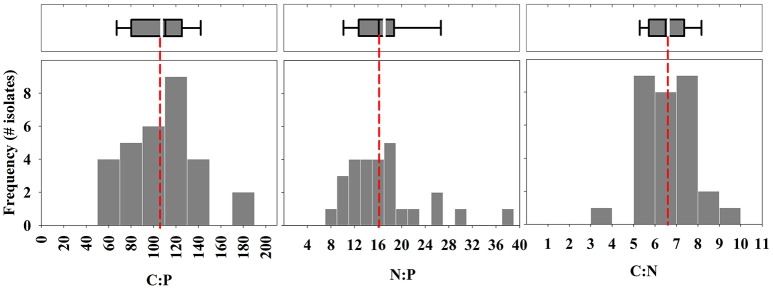
Frequency of isolates within binned intervals of molar elemental ratios of carbon, nitrogen, and phosphorus. Bin intervals for C:P, N:P, and C:N are 20, 2, and 1, respectively. Top box-whisker plots include the mean (white line) and median (black line) of ratios for all 30 isolates. The box indicates quartiles and the dotted line provides a reference to the Redfield ratio of C:N:P (106:16:1).